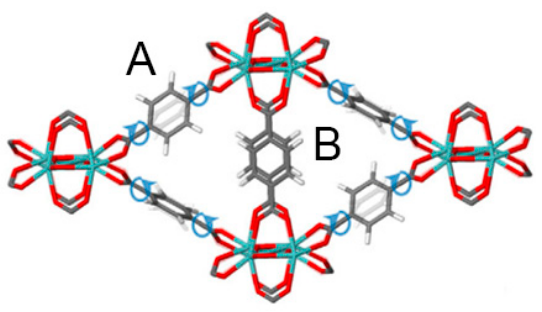
Figure 10. Structure of MIL-140A, terephthalate linkers in two different positions (A and B). Reproduced with permission from [24]. Copyright American Physical Society, 2017.